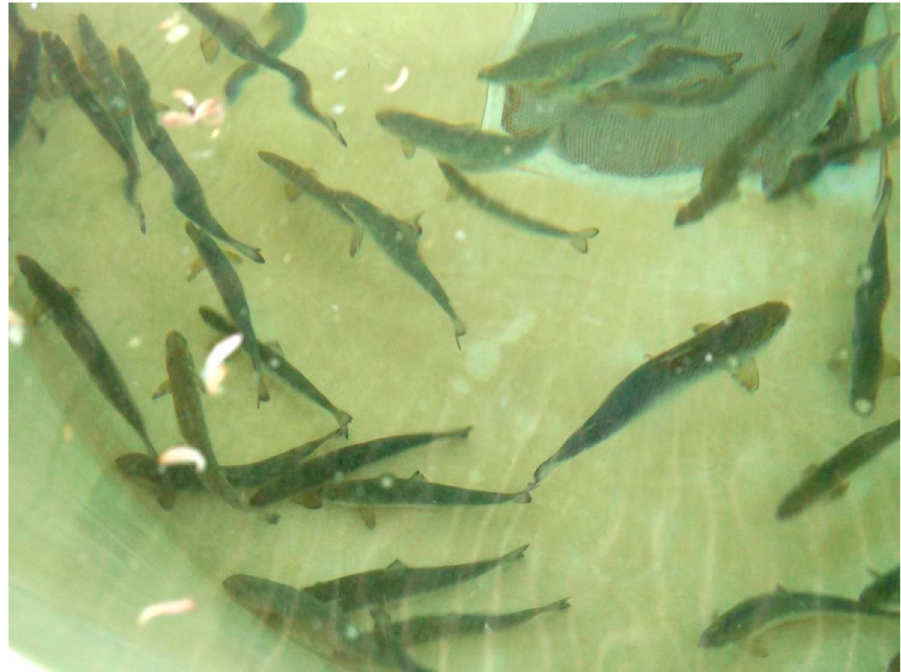
Figure 15. Salmon swimming in the tanks and showing normal behaviour.